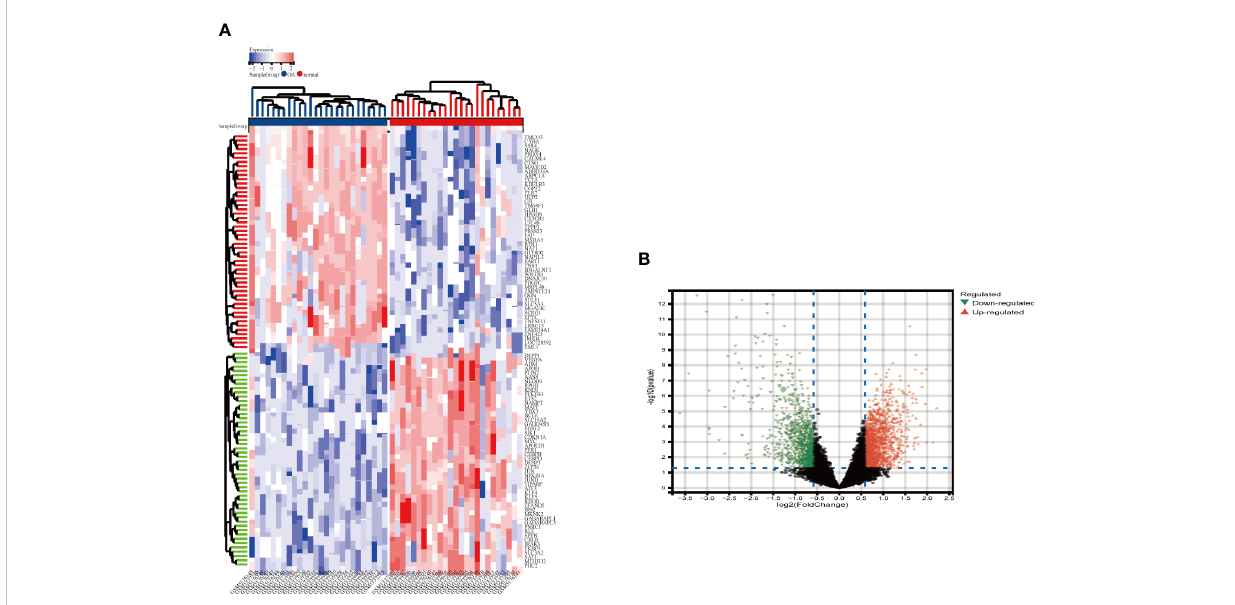
FIGURE 2 Heatmap and valcano plot for the DEGs identi fi ed from the integrated OA dataset. (A) Each row shows the DEGs, and each column refers to one of the samples of OA cases or controls. The red and blue represent DEGs with upregulated and downregulated gene expression, respectively. (B) Red and green plot triangles represent DEGs with upregulated and downregulated gene expression, respectively. OA, Osteoarthritis: DEGs, differentially expressed